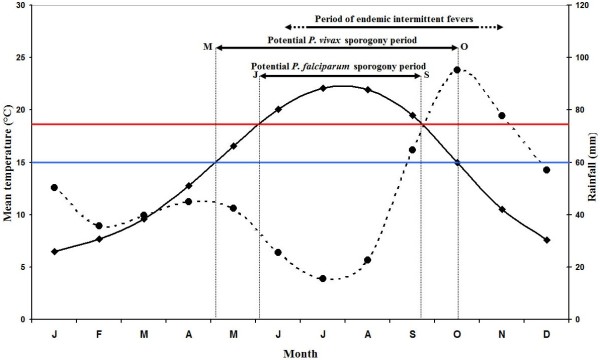
Marseille climate diagram for the 1745–1850 period. Average temperatures (solid line) and precipitation (broken line). The horizontal blue and red lines indicate minimal temperatures required for P. vivax (15°C) and P. falciparum (18°C) development, respectively. These figures are not precise thresholds, but they illustrate a climate above which temperatures are generally favourable for transmission.